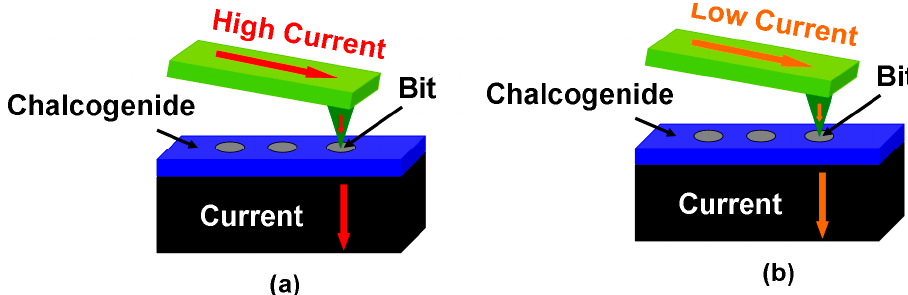
Figure 2. The electrical probe memory using Chalcogenide media when operated in ( a ) write mode and ( b ) readout mode.